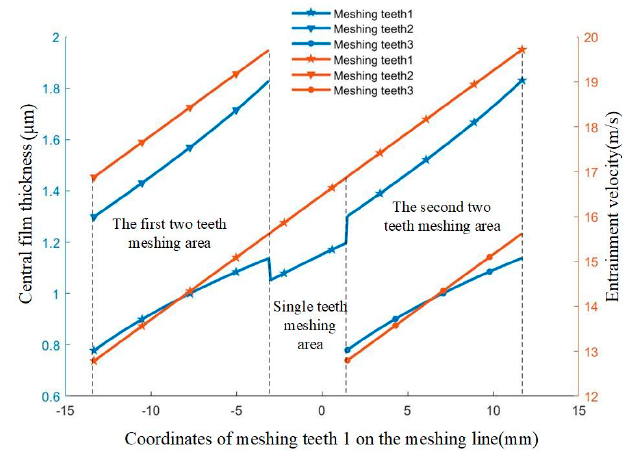
Figure 2. Central film thickness and entrainment velocity during the meshing process.